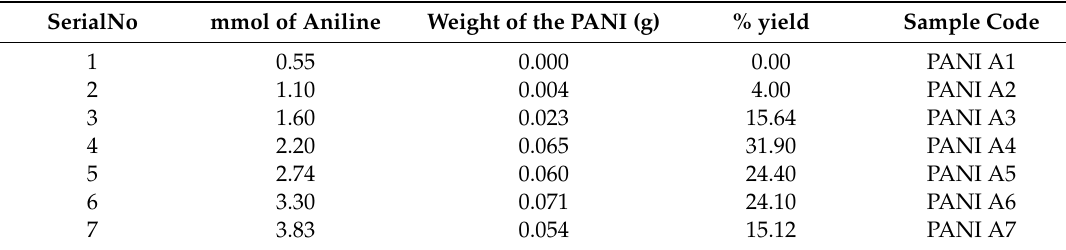
Table 2. E ff ect of amount of monomer (aniline) on percent yield of PANI. SerialNo mmol of